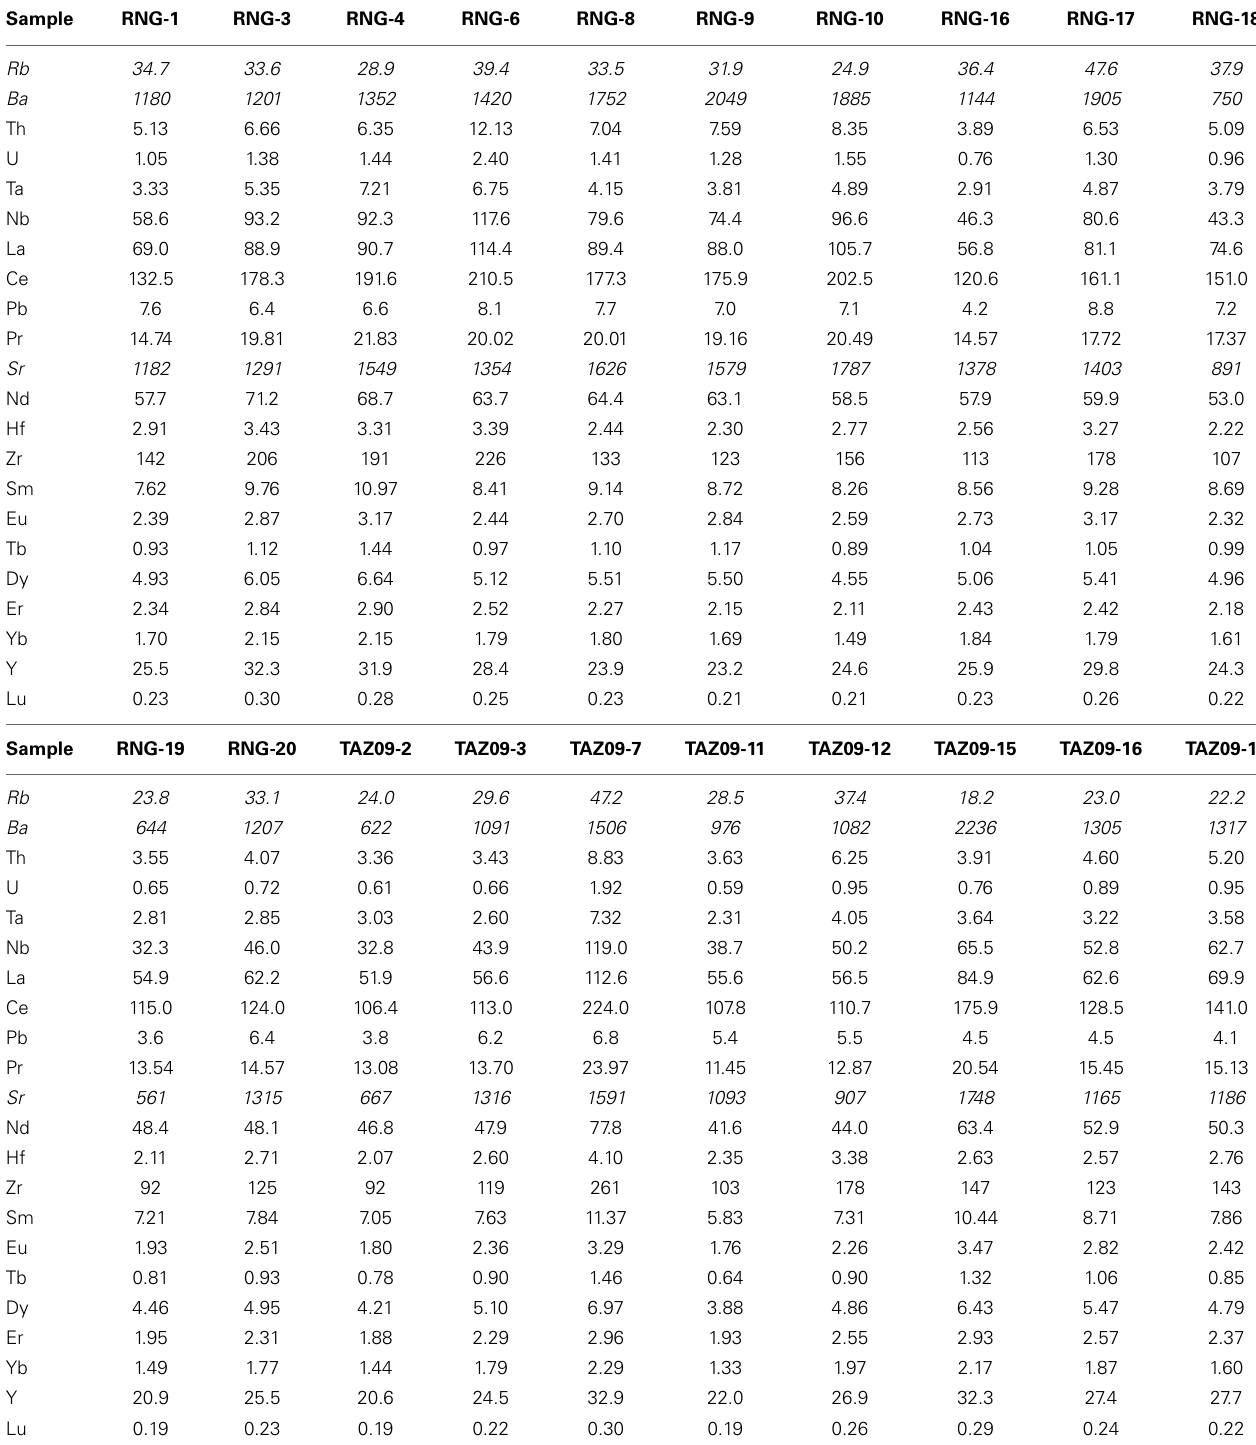
Table 1 | Trace element composition of RVP basaltic rocks and tephras.